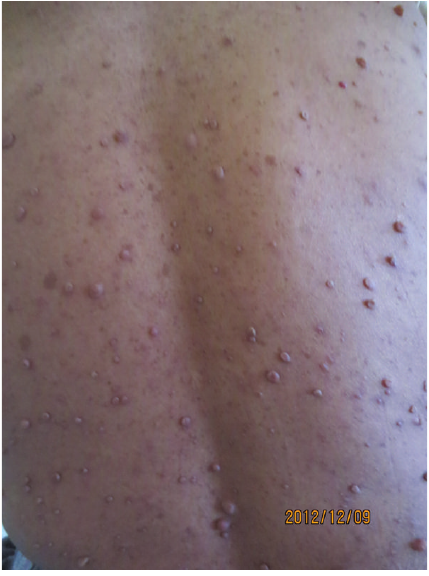
Figure 3: Common neurofibromas and “caf´e-au-lait” spots on thoracolumbar